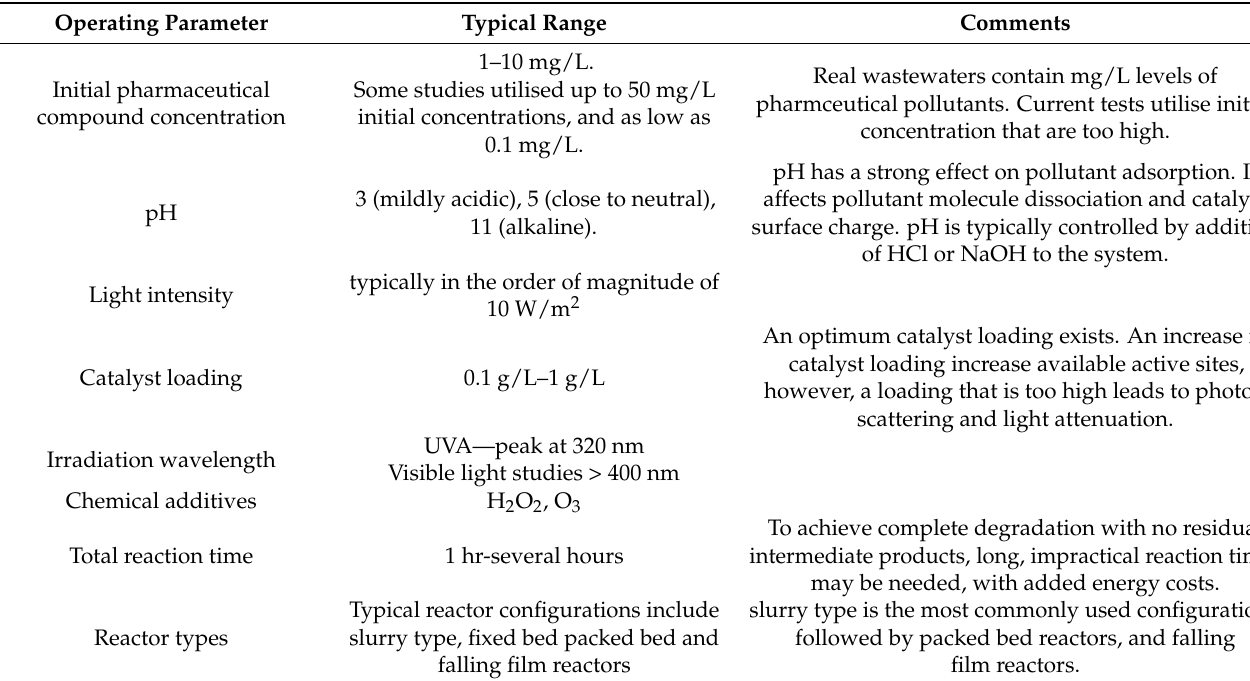
Table 3. Operating parameters for heterogeneous photocatalytic removal of pharmaceutical com- pounds and their typical ranges